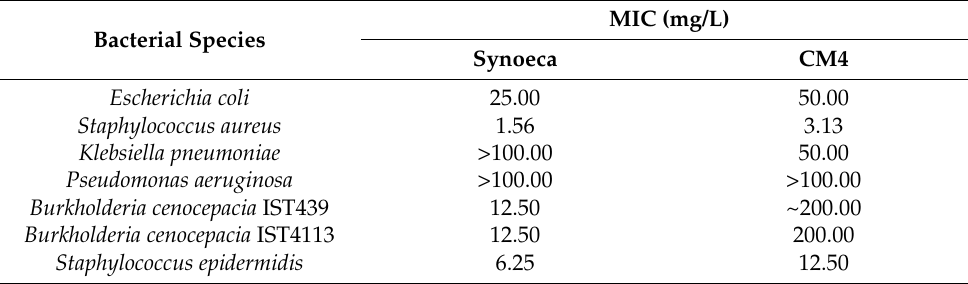
Table 2. Synoeca and CM4 MICs against different